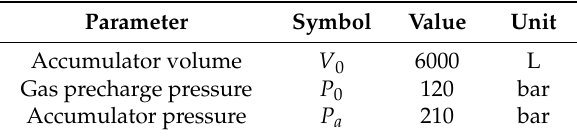
Table 2. Main parameters of energy storage system.